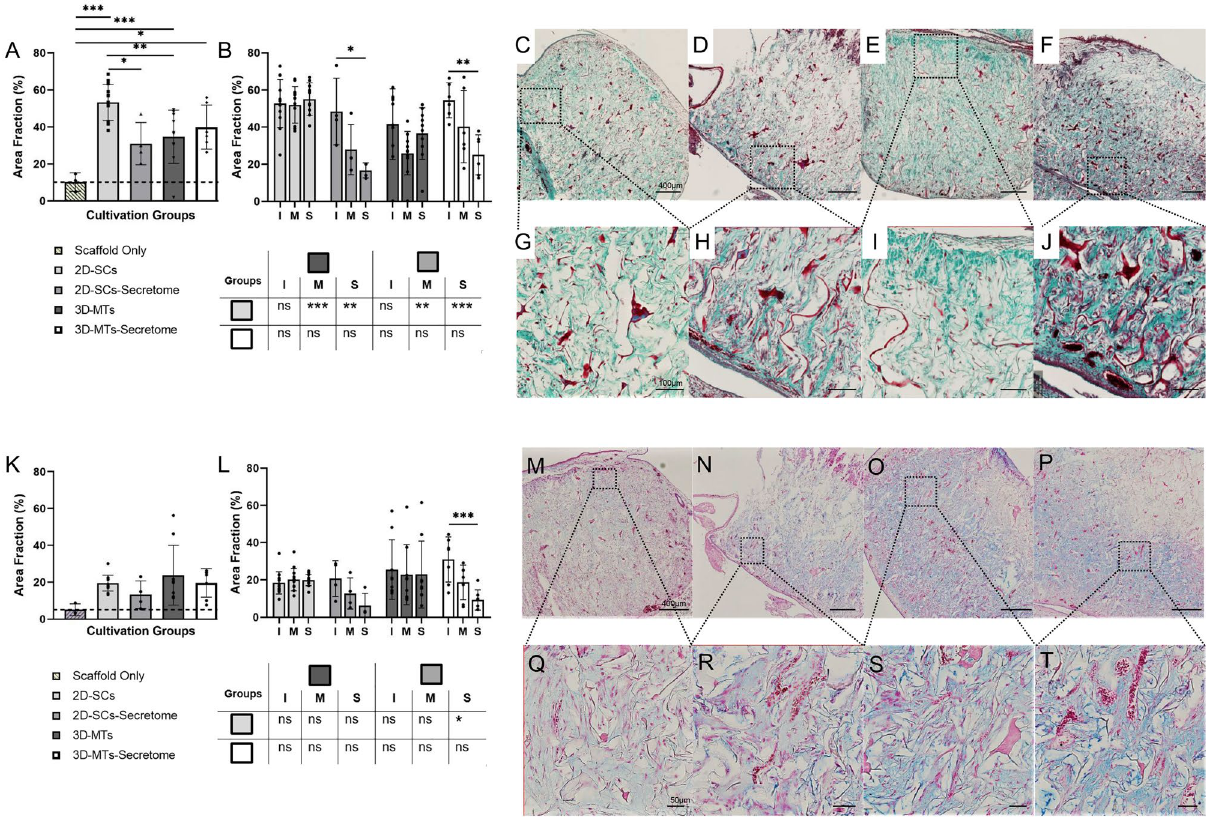
Figure 4. Histological analysis of collagen and glycosaminoglycan formation into the natural collagen scaffold (Optimaix). Histological analysis of collagen ( A – J ) and GAG ( K – T ) of the four cultivation groups are assessed on day 7. An additional scaffold only group was assessed to provide a reference what amount is stained by the scaffold itself. Results are presented in a group comparison of the total scaffold ( A , K ) and more specified in differing three ROIs (interface (I), middle (M) and the surface (S)) ( B , L ). Significances of intra-group calculations are demonstrated within the graph whereas inter-group differences with its corresponding ROIs are shown on the separate tables. The results are illustrated with an exemplary out-take of each cultivation group using single-cells ( C , G , M , Q ), 2D-SCs-secretome ( D , H , N , R ), 3D-microtissues ( E , I , O , S ), 3D-MT-Secretome ( F , J , P , T ). An exemplary part of the interface region is shown for each group ( G – J , Q – T ). The scale bar was defined with 400 µm in the overview examples ( C – F , M – P ) in both stains and 100 µm for the more